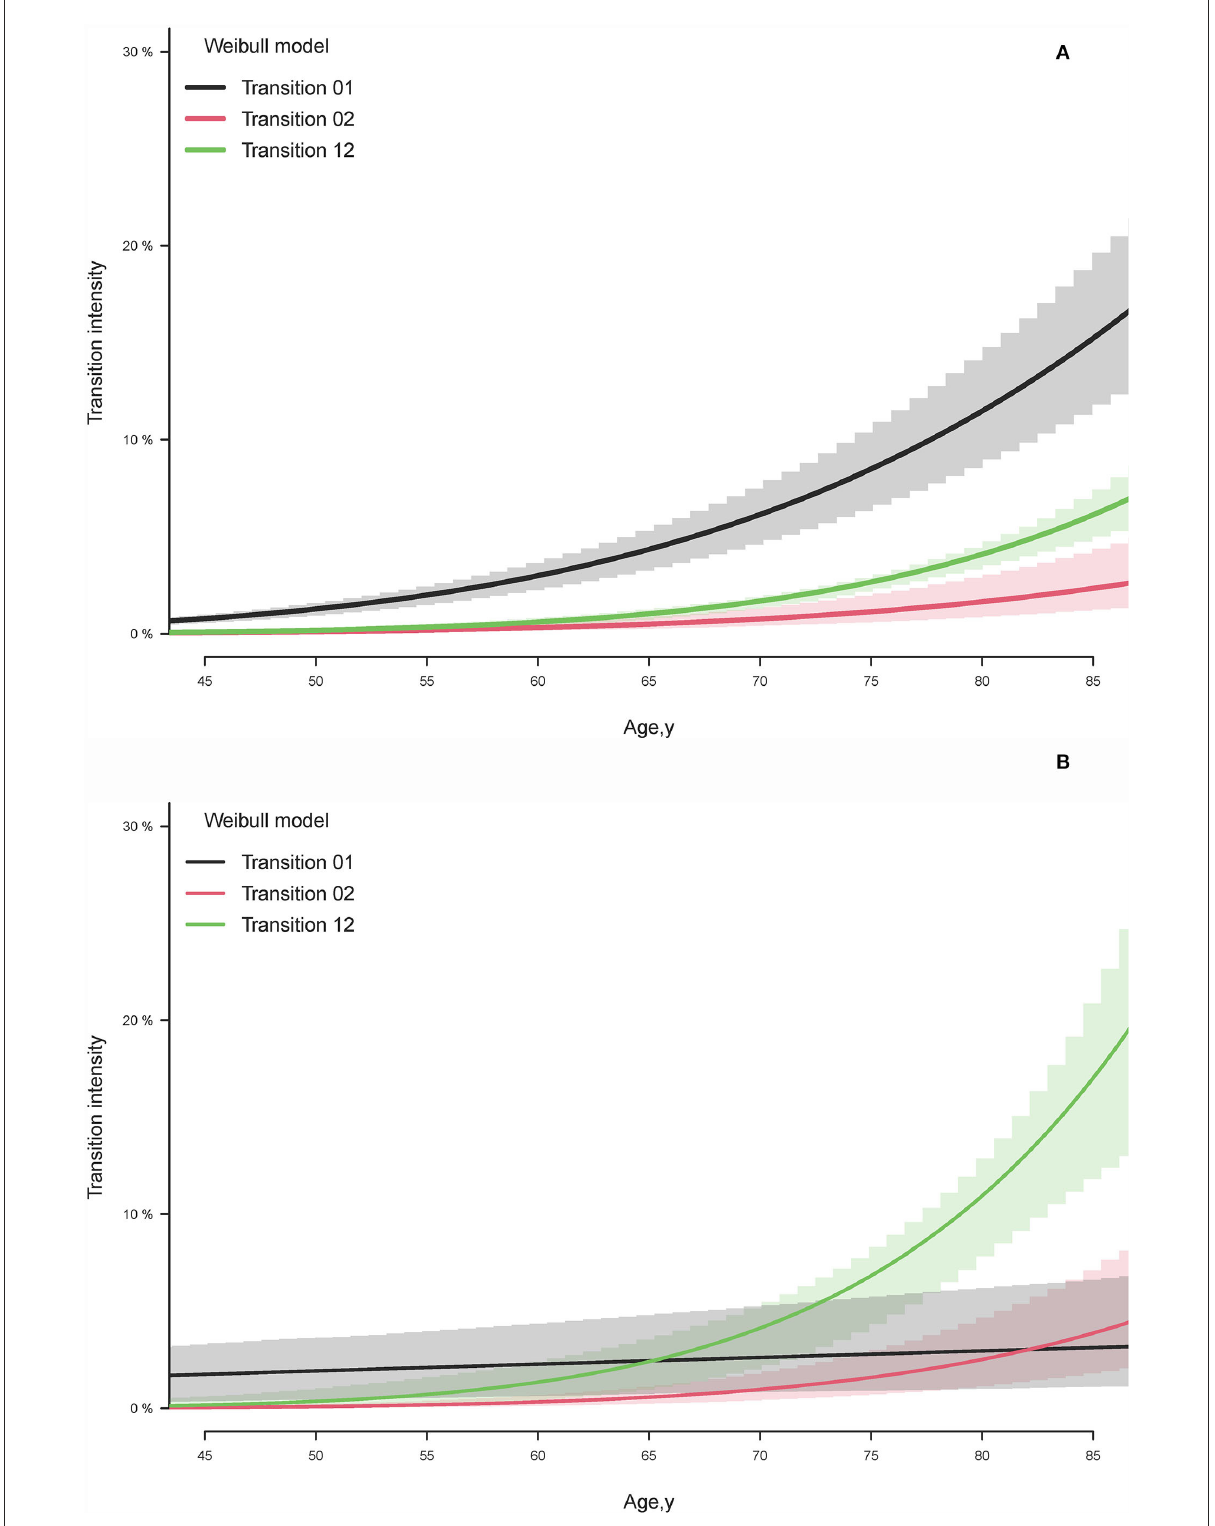
FIGURE2 Estimated baseline transition intensity by illness-death model for (A) estimated glomerular filtration rate (eGFR) < 60 state and death transitions in the cohort with baseline eGFR ≥ 60 ml/min/1.73 m 2 and (B) eGFR < 30 state and death transitions in the cohort with baseline eGFR 59–30 ml/min/1.73 m 2 . Transition 01 represents the transition intensity from the baseline state to the selected state. Transition 02 exhibits the transition intensity from the baseline state to death. Transition 12 displays the transition to death after transiting the selected state from the baseline